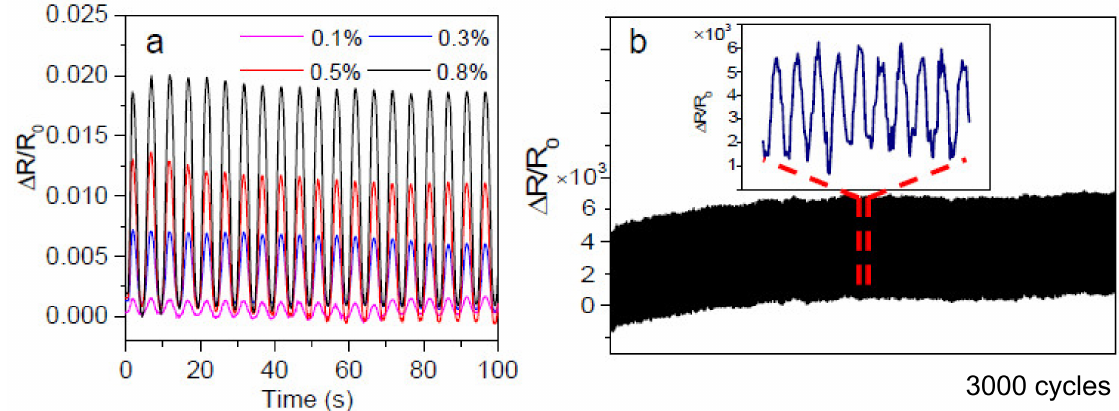
Figure 10. Relative change in resistance ( ∆ R / R 0 ) with applied cyclic tensile loading for the CP_0.38GO. ( a ) Up to 10 cycles; ( b ) up to 3000 cycles.